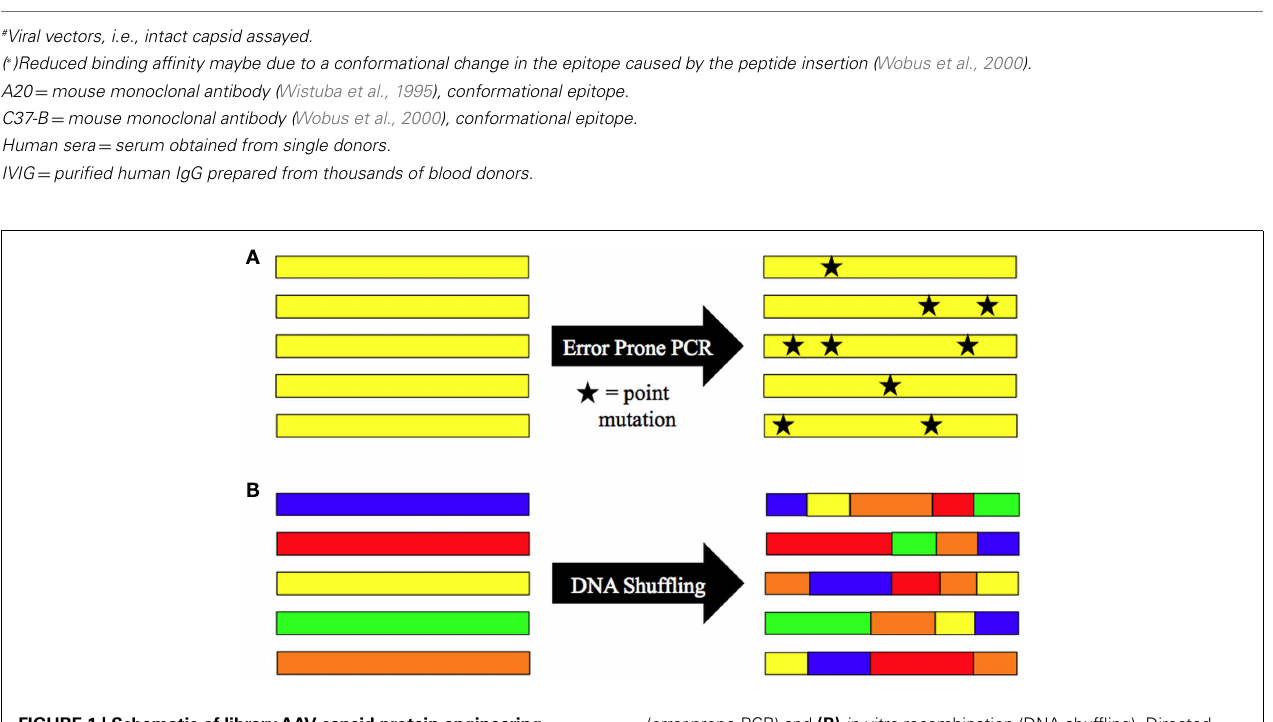
FIGURE 1 | Schematic of libraryAAV capsid protein engineering strategies for evasion of antibody neutralization. Methods for